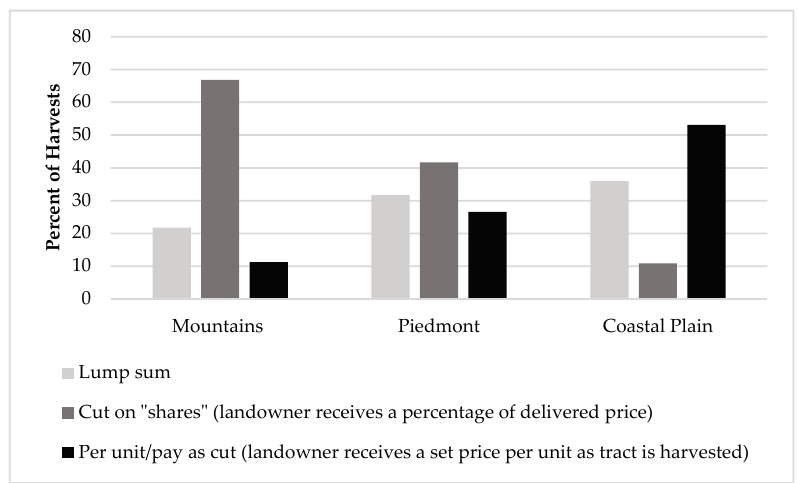
Figure 5. Reported sale type for timber bought by loggers.